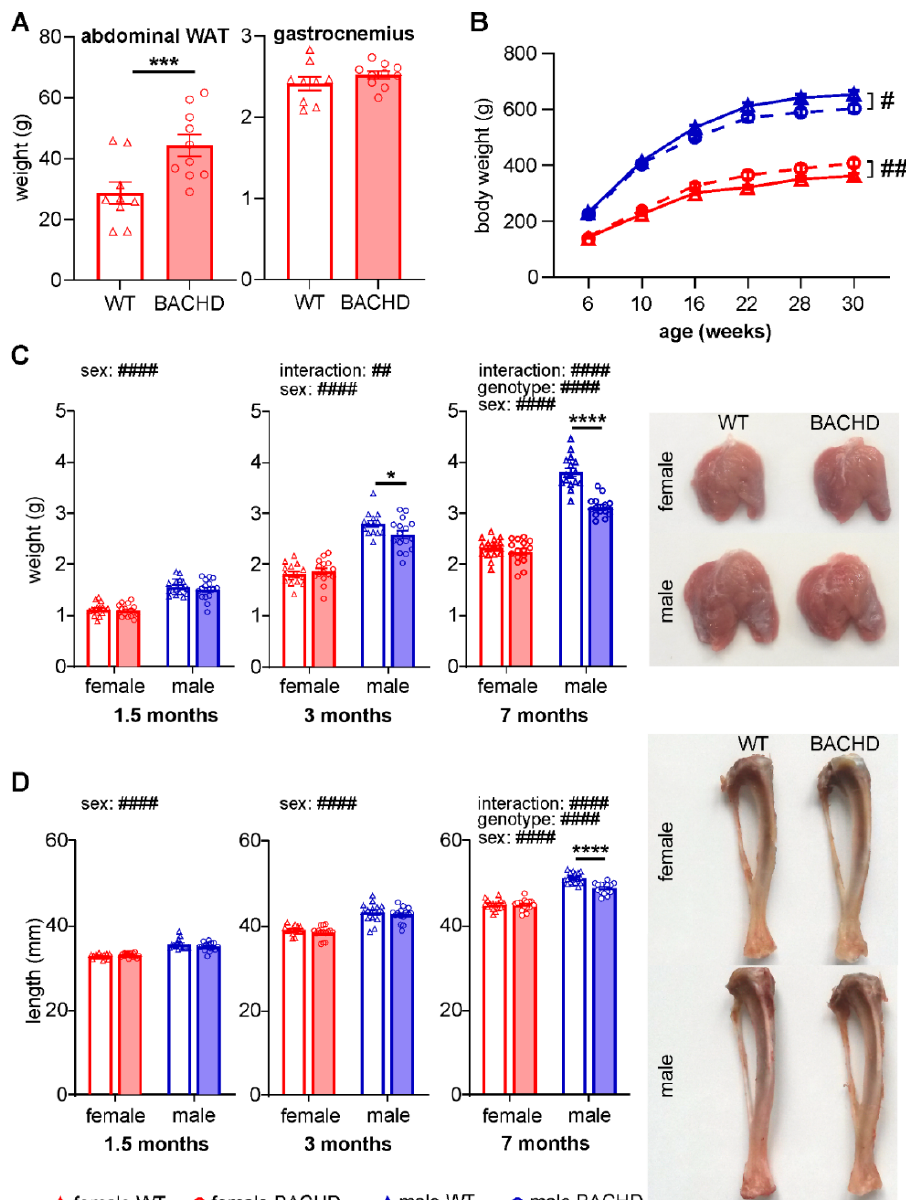
Figure 1. Sex-differences in body weight gain in BACHD rats and reduced musculoskeletal growth in male BACHD rats. ( A ) Abdominal white adipose tissue (WAT) and gastrocnemius weight in female BACHD rats and WT littermates at 12 months of age ( n = 12/genotype). ( B ) Longitudinal analysis of body weight in female and male WT and BACHD rats from 6 to 30 weeks of age ( n = 16/genotype/sex). ( C ) Gastrocnemius weight and ( D ) tibia length in three age groups: young (1.5 months), young adult (3 months) and middle-aged adult (7 months) ( n = 12–16/genotype/sex/age). Right panels in C and D show representative images of gastrocnemius and tibia, respectively. Statistical significance was determined by two-tailed unpaired Student’s t -test in A, two-way repeated measures ANOVA followed by Tukey’s post-hos test in B, and regular two-way ANOVA followed by Sidak’s post-hoc test in C and D. Data are expressed as mean values ± SEM. # indicates the results of ANOVA analyses ( B – D ); * indicates the results of t -test ( A ) and post-hoc test ( C , D ). # p ≤ 0.05; ## p ≤ 0.01; *** p ≤ 0.001; ####/**** p ≤